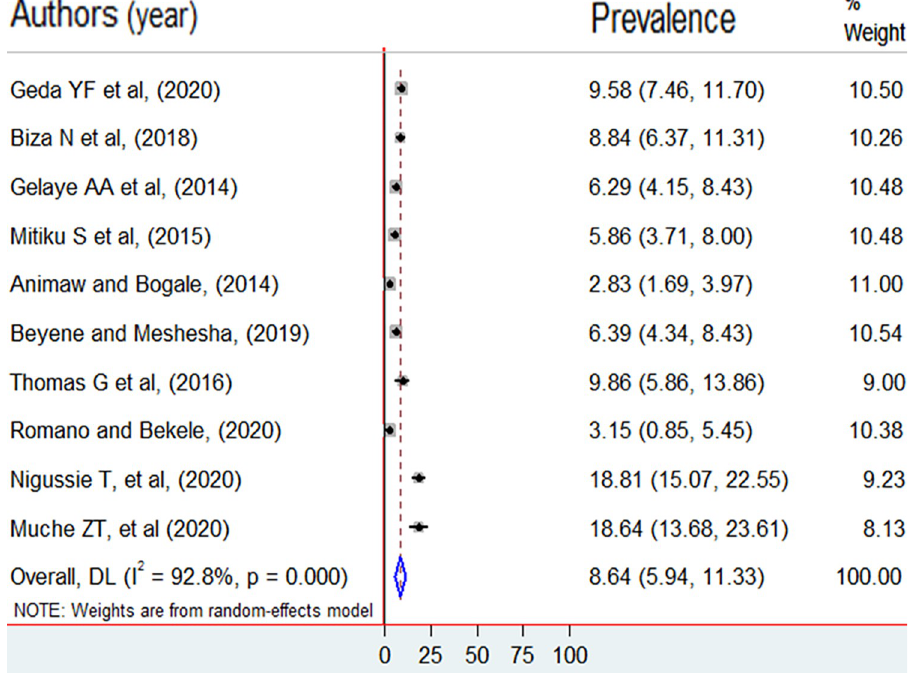
Fig 2. The prevalence of induced abortion among female students in higher education institutions in Ethiopia, 2011 to 2021.